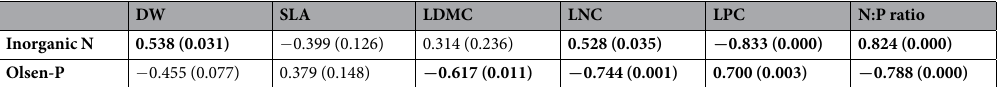
Table 2. Pearson’s correlation coefficients ( P values in the parenthesis) between crown average values of needle traits and soil available nutrients. DW individual needle dry weight, SLA specific leaf area, LDMC leaf dry matter content, LNC leaf N concentration, LPC leaf P